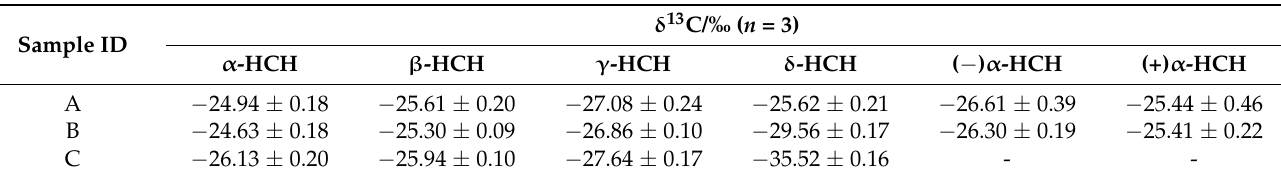
Table 3. The δ 13 C values of HCHs from different manufacturers.